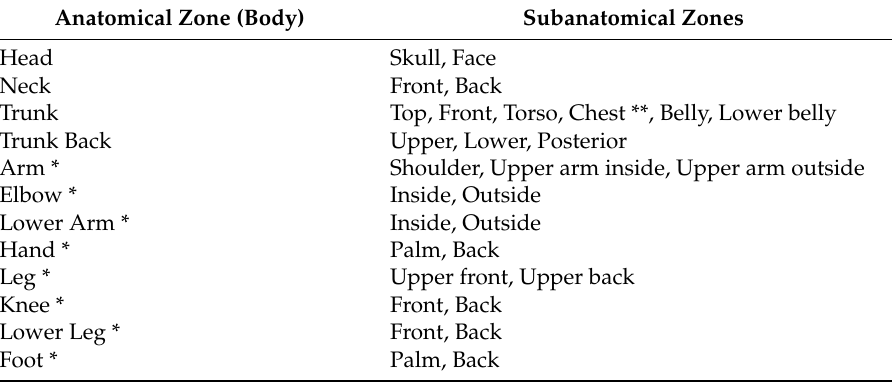
Table 1. Detailed anatomical regions and subregions for the human model in SimUVEx.